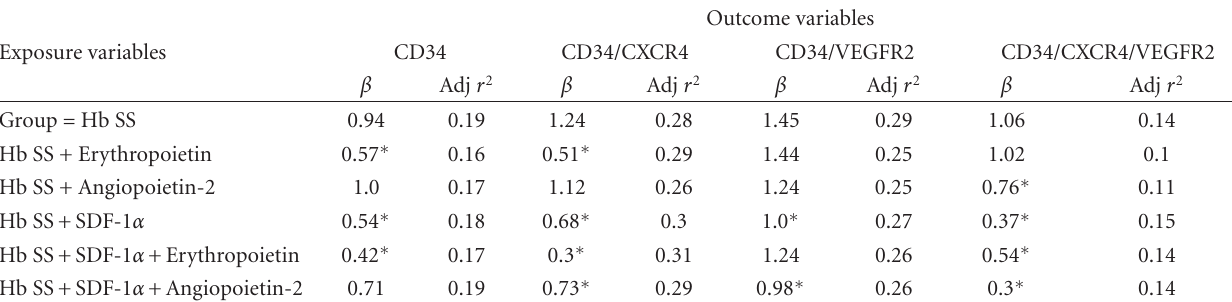
Table 5: Multivariate linear regression showing relationship between Hemoglobin SS group, angiogenic growth factors, and CPC populations. SDF-1 α was consistently associated with the relationship between Hemoglobin SS status and all CPC types (highlighted). Significant reductions in the beta-coe ffi cient ( > 25%) compared to the main exposure variable are marked with an asterisk ( ∗ ).